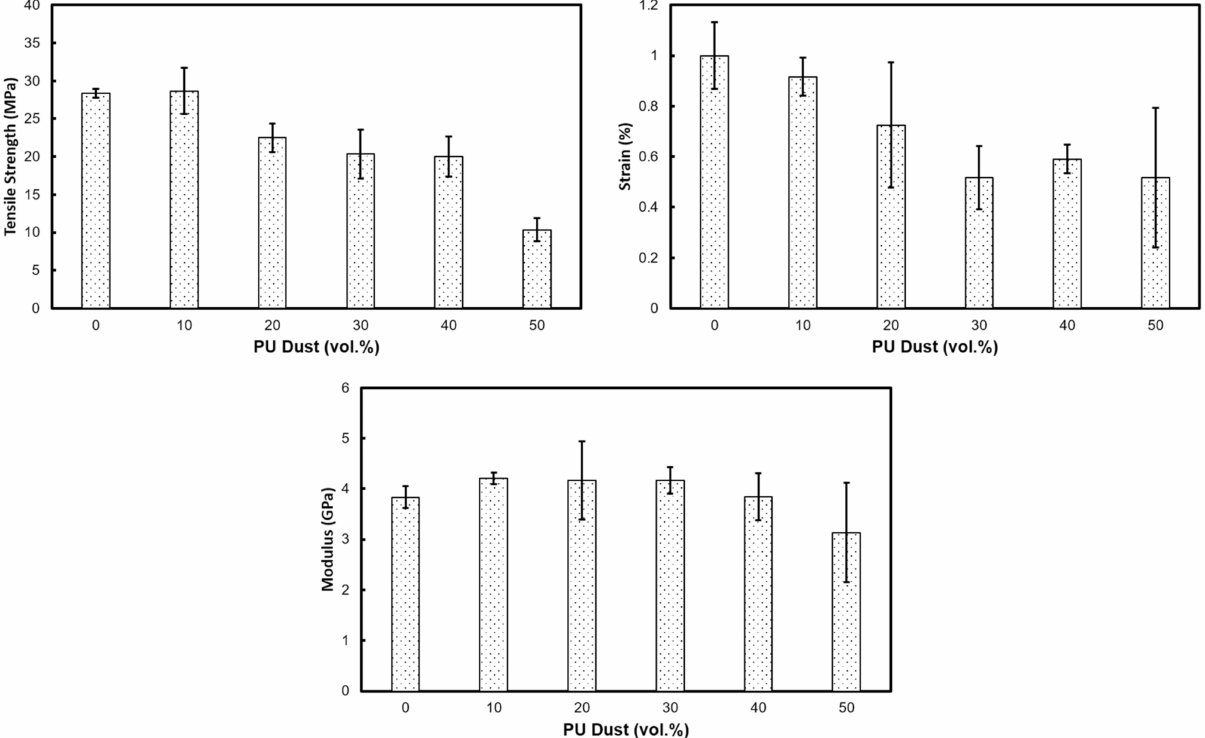
Figure 11. Tensile strength properties of UPR-PUD